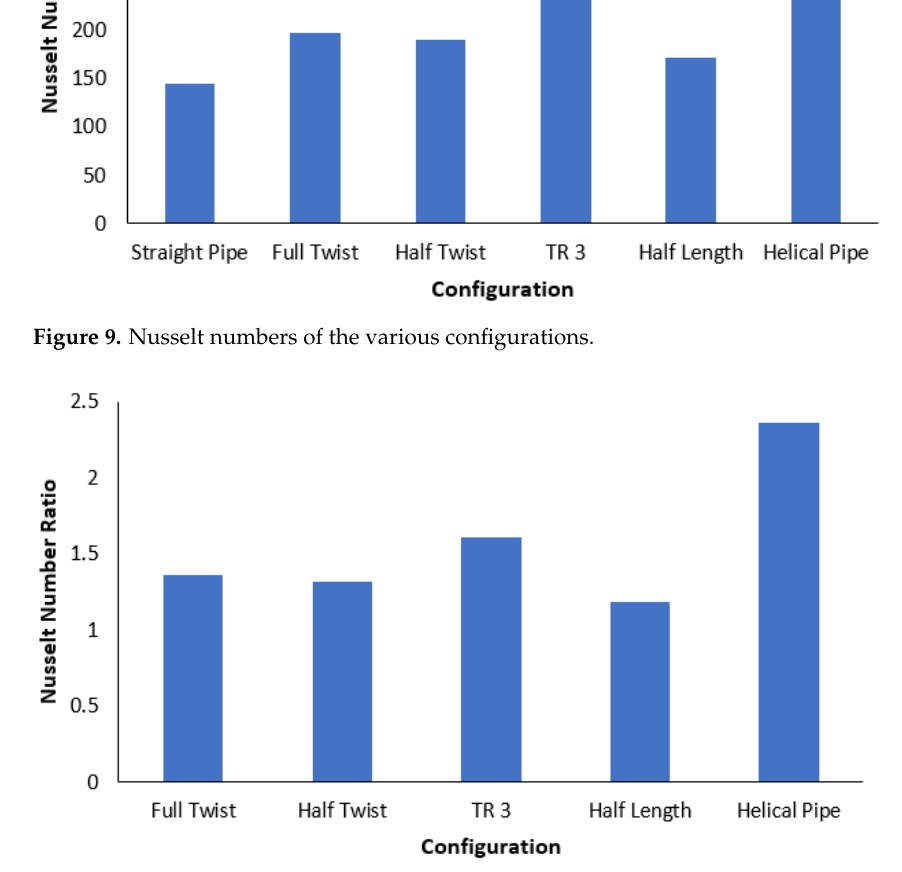
Figure 10. Nusselt numbers of the various configurations compared to the straight pipe.